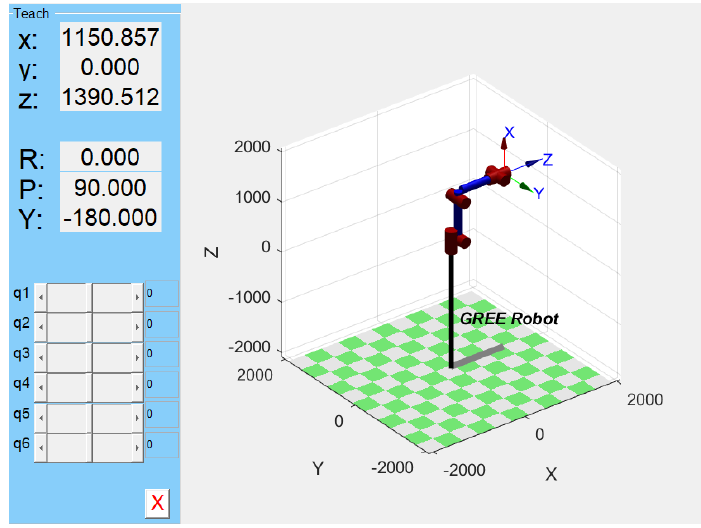
Figure 3. Three-dimensional model of robot.